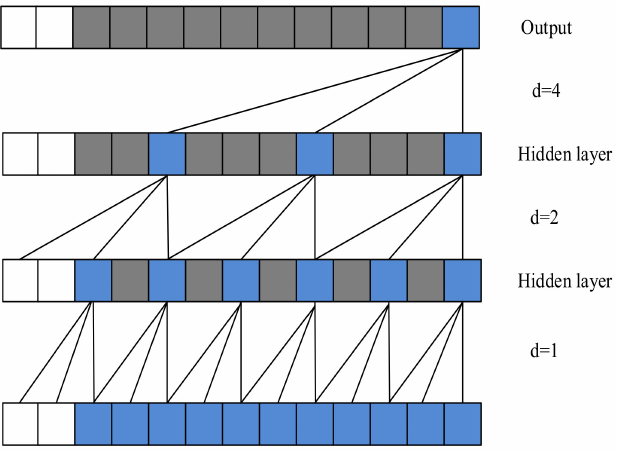
Figure 2. Basic TCN network structure.